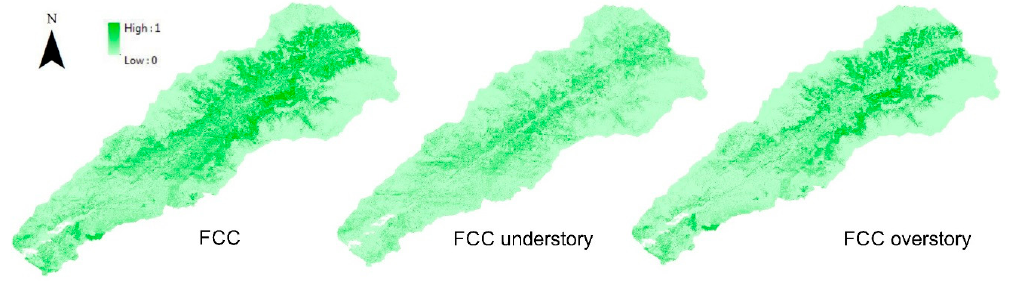
Figure 6. Types of canopy cover.